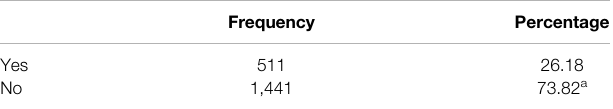
TABLE 6 | Feedback from teachers (n (cid:1) 154).